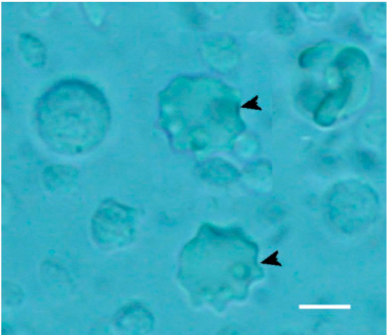
Figure 11. Newly di ff erentiated dendritic cells (arrowheads) indicating activation of the innate immune system in PBM cells treated with paramylon nanofibers. Bar 10 µ